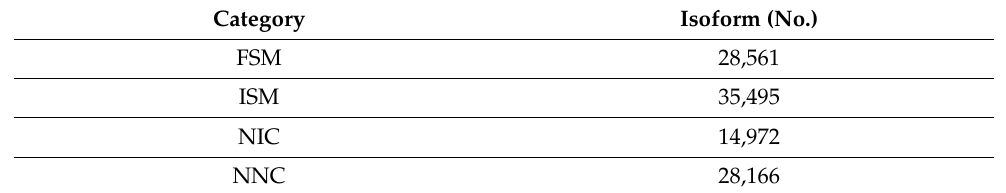
Table 2. Characterization of transcripts based on splice junctions. Abbreviations: FSM, full splice match; ISM, incomplete splice match; NIC, novel in catalog; NNC, novel not in